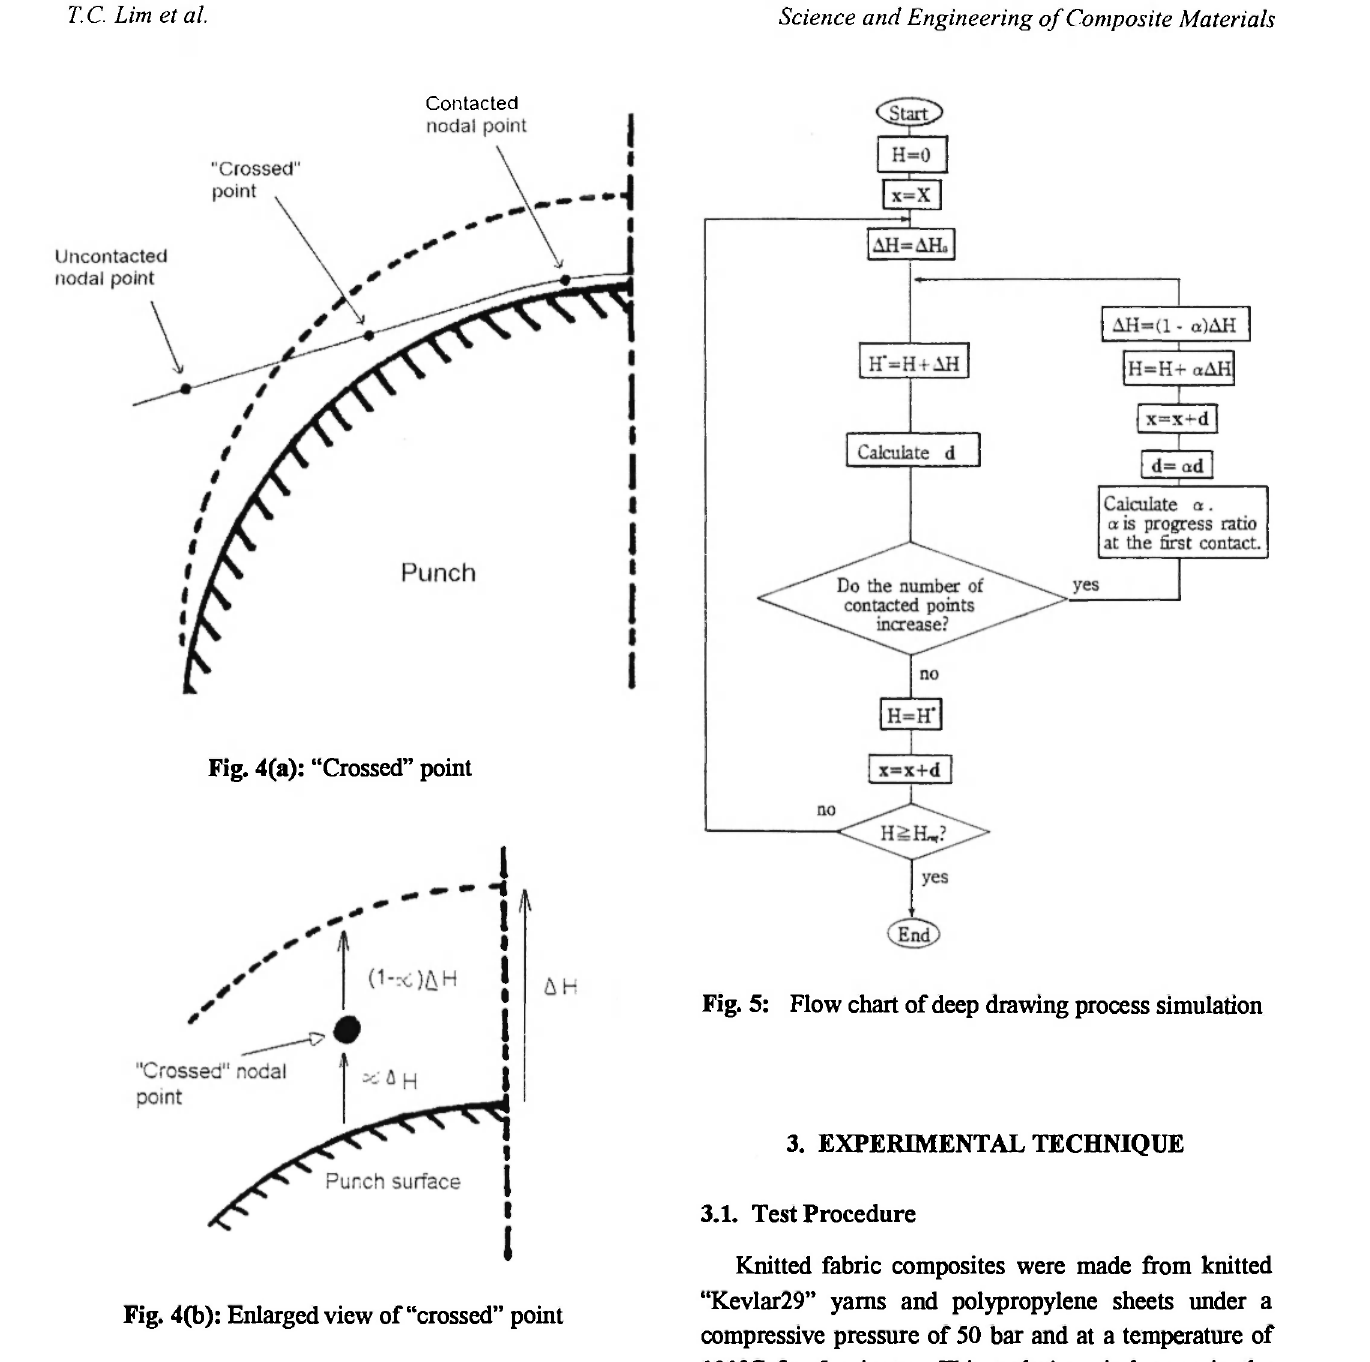
Fig. 4(b): Enlarged view of "crossed" point